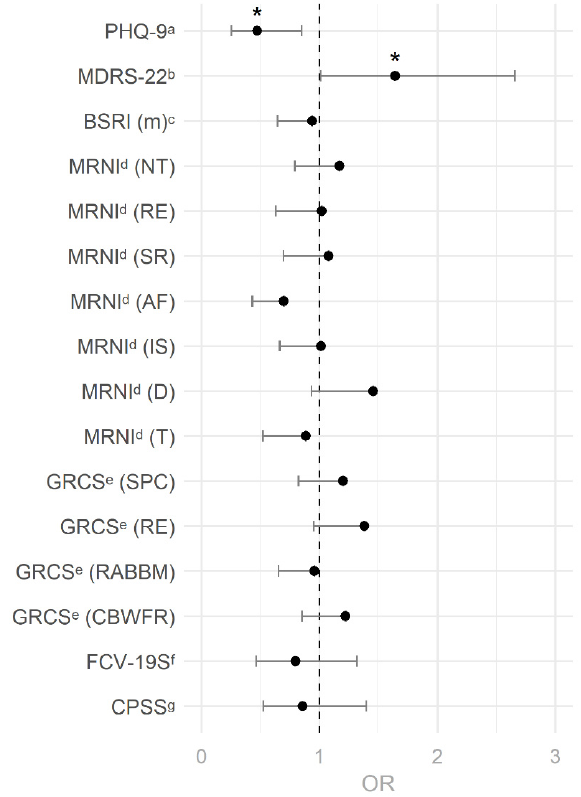
Figure 3. Standardized odds ratios for COVID-19 infection and their two- and one-sided 95% confidence intervals. Note: OR = Odds ratio; a PHQ-9 = Patient health Questionnaire-9; b MDRS-22 = Male Depression Risk Scale-22; c BSRI (m) = Bem Sex-Role Inventory (masculinity subscale); d MRNI = Male Role Norms Inventory (subscales: NT = Negativity toward Sexual Minorities; RE = Restrictive Emotionality; SR = Self-reliance through Mechanical Skills; AF = Avoidance of Femininity; IS = Importance of Sex; D = Dominance; T = Toughness; e GRCS = Gender Role Conflict Scale (subscales: SPC = Success, Power, Competition; RE = Restrictive Emotionality; RABBM = Restrictive Affectionate Behavior Between Men; CBWFR = Conflicts Between Work and Leisure–Family Relations); f FCV-19S = Fear of COVID-19 Scale; g CPSS = COVID-19 Pandemic Stress Scale. * = p < 0.05.